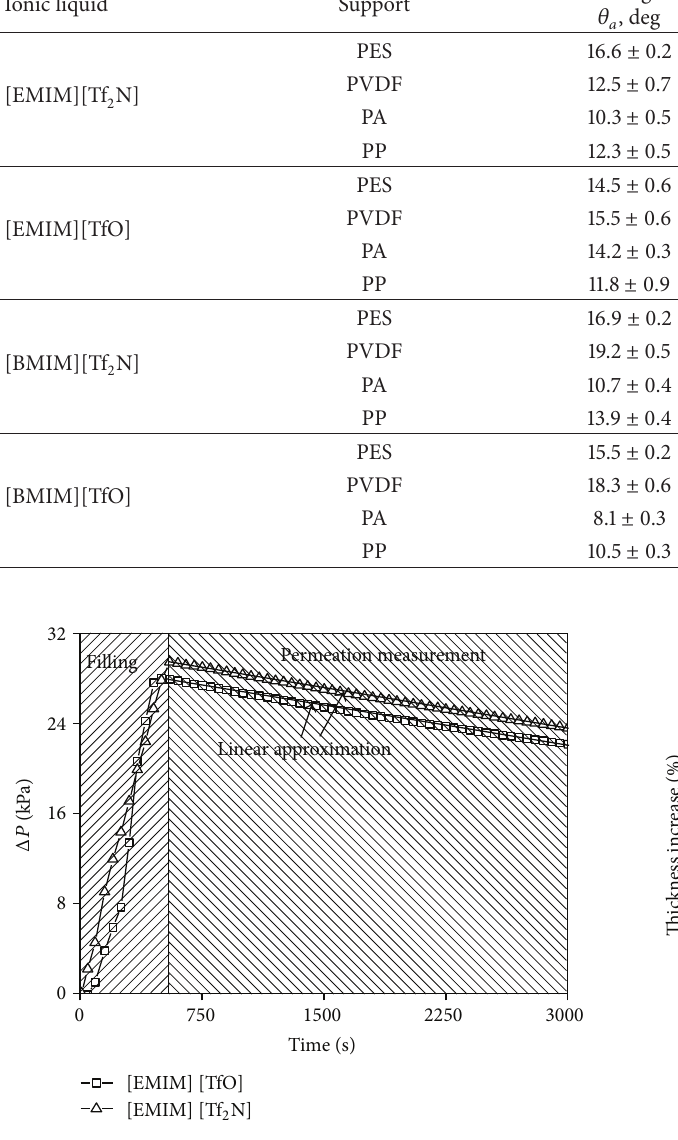
Table 4: Wettability of polymeric supports by ionic liquids determined by sessile drop method at 298 K [36]. Ionic liquid